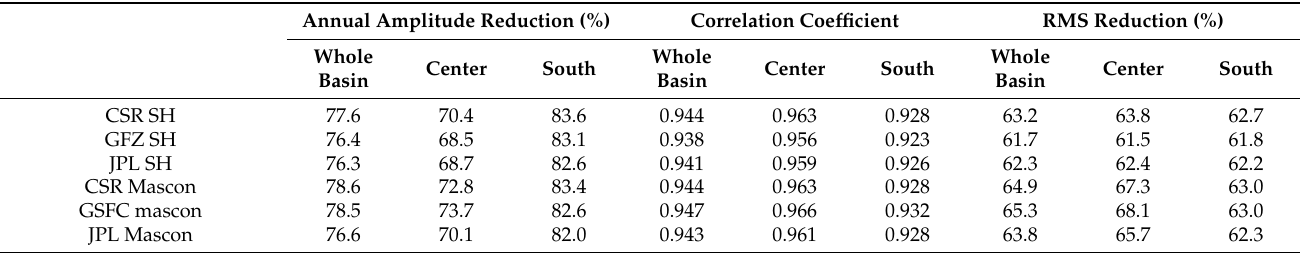
Table 3. Mean values of the correlation coefficients, annual amplitude reductions, and RMS reductions at the 22 GNSS stations calculated in the central and southern parts of the Amazon